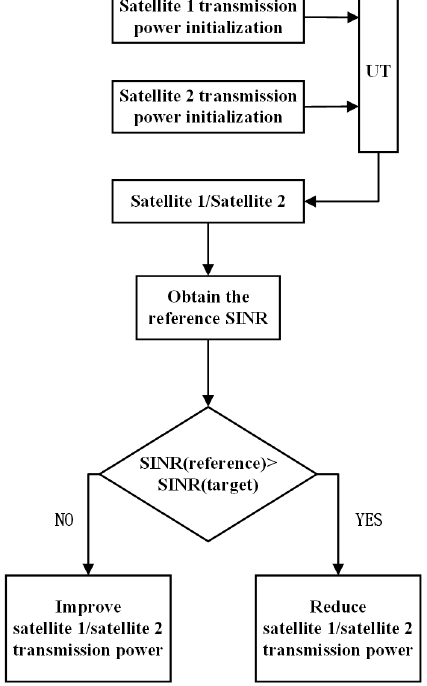
Figure 5. Diagram of closed-loop power